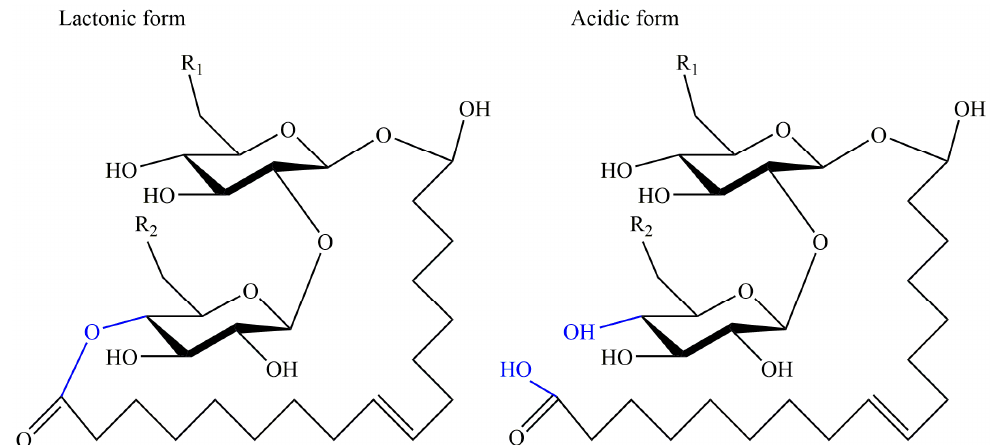
Figure 3. Common structures of sophorolipids: lactonic form and acidic form. R 1 = OH or OCOCH 3 , R 2 = OH or OCOCH 3 .